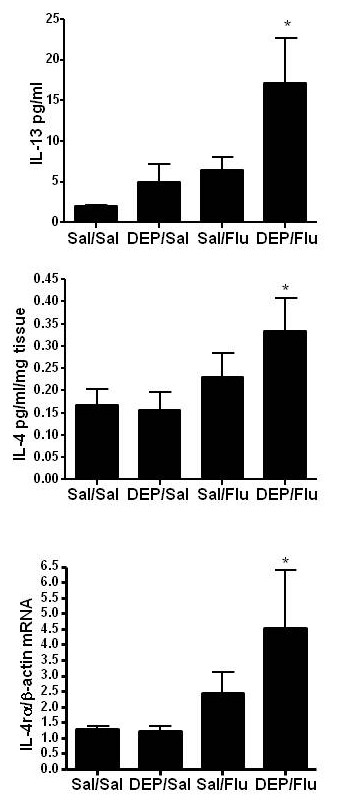
Exposure to DEP prior to infection with influenza increases markers of Th2-type immune response. A.) Cell-free BALF was analyzed for IL-13 levels. B.) Whole lung homogenates were analyzed for IL-4 levels. C.) Total RNA isolated from whole lung was analyzed for IL-4rα mRNA levels and normalized to β-actin mRNA levels. *significantly different from Sal/Sal control; p < 0.05.